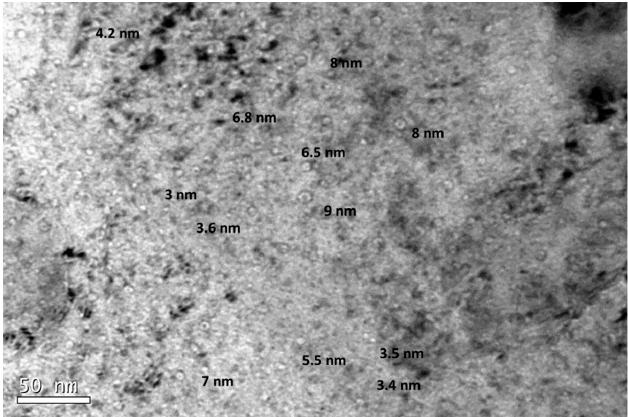
Figure 10. Under-focused TEM micrograph from zone A (716–657 appm He) of EU-ODS EUROFER annealed at 450 °C for 100, including the diameters of some representative